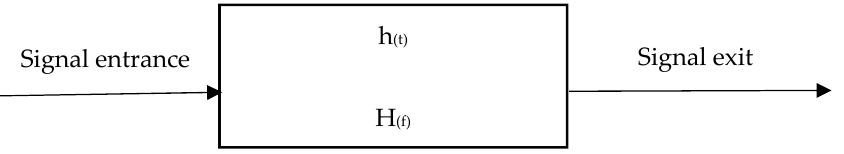
Figure 1. A dynamical system is characterized in time domain h (t) or in frequency domain H (f).